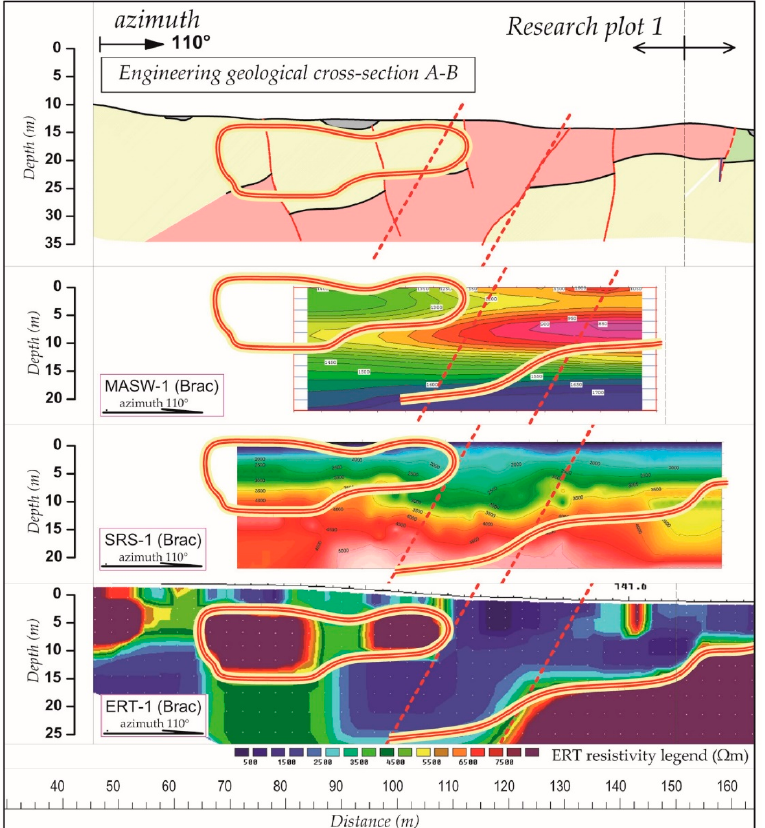
Figure 10. The process of the geophysical profiles overlaying to create the composite geophysical data needed to create the engineering geological profile. Boundary elements lines are shown on top of each geophysical profile to visually depict comparable zones between profiles. The top image is the resulting engineering geological cross-section of the process.